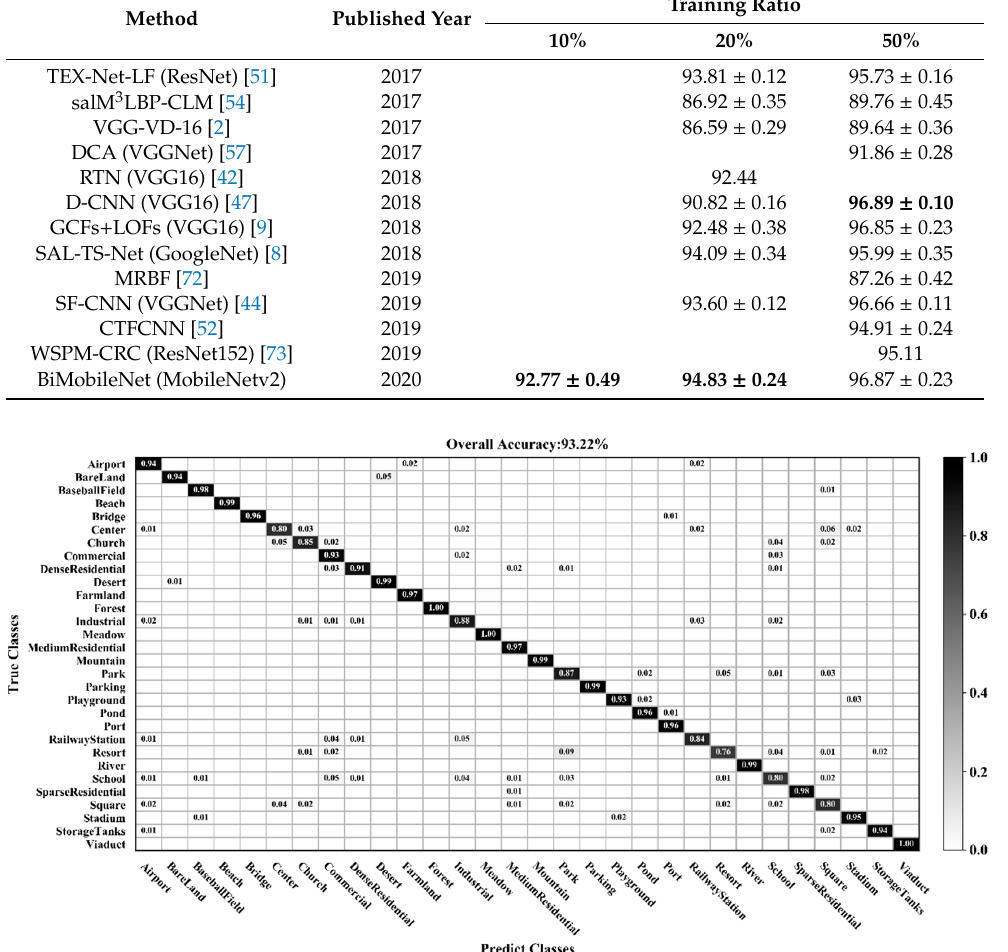
Sensors 2020 , 20 , x FOR PEER REVIEW Figure 13. Confusion matrix using a training ratio of 10% on the AID dataset. Figure 13. Confusion matrix using a training ratio of 10% on the AID dataset.